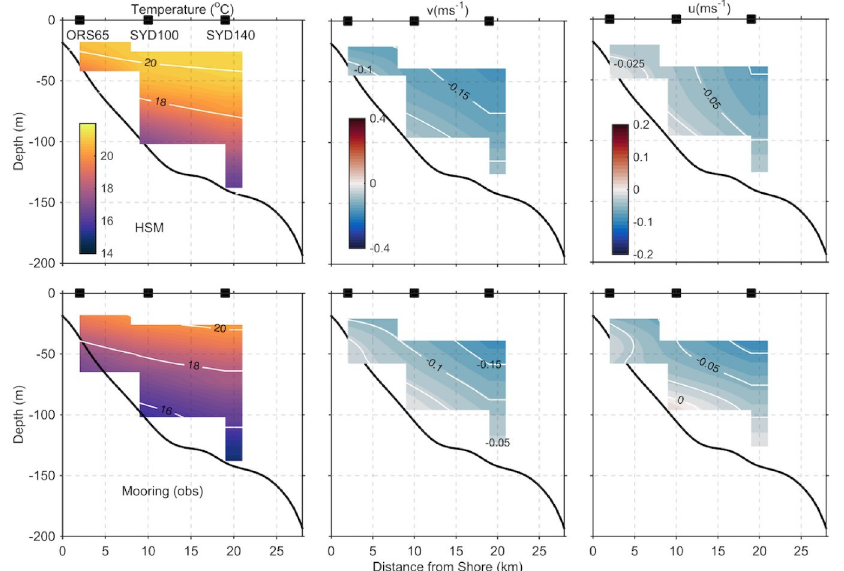
Fig 6. Modelled (top panel) and observed (bottom panel) cross-sections of the mean temperature (left column), along-shelf velocity (middle column, negative poleward) and cross-shelf velocity (right column, negative onshore) off Sydney (34 o S). The positions of the 3 moorings are indicated by black